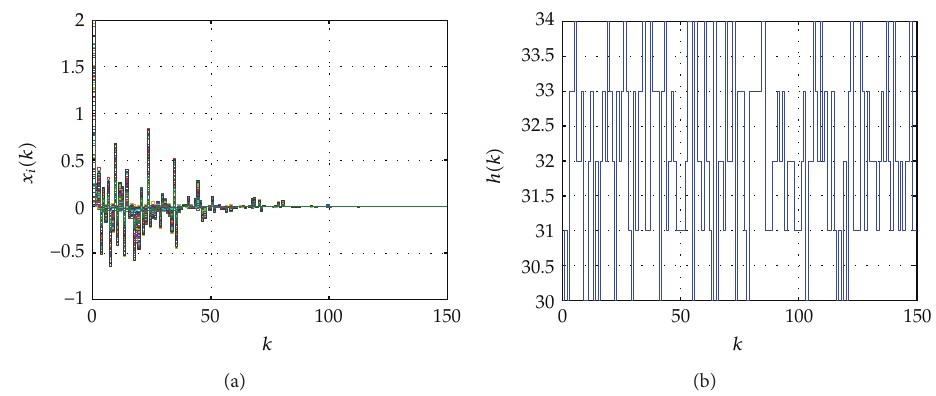
Figure 8: State responses and time-delay ℎ(𝑘) with C2-2 (Example